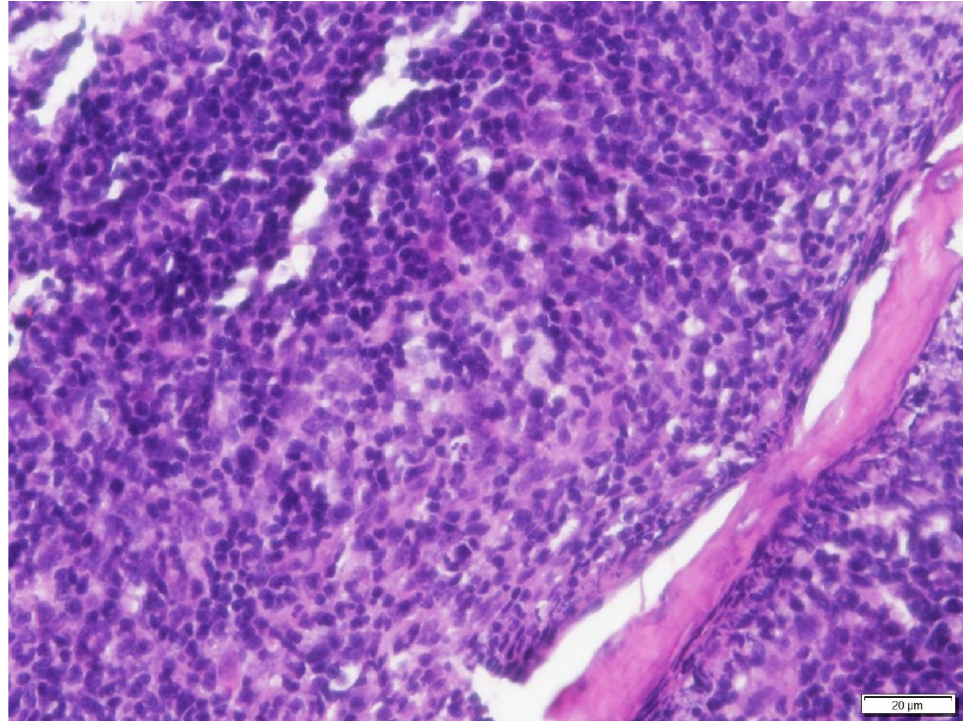
Figure 8. Higher magnification of the neoplastic cells in Case N.3. Neoplastic round cells had round to oval nucleus, finely stippled to finely clumped to hyperchromatic chromatin and 0 to 2 distinct, small to medium, magenta nucleoli. Infiltrating among neoplastic cells were variable numbers of small mature lymphocytes and neutrophils. H&E stain (400× magnification).